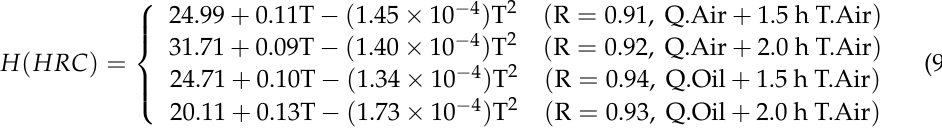
Figure 11. Tempering hardness equation: ( a ) hardness-temperature fitting curves; ( b ) tempered hardness curves.